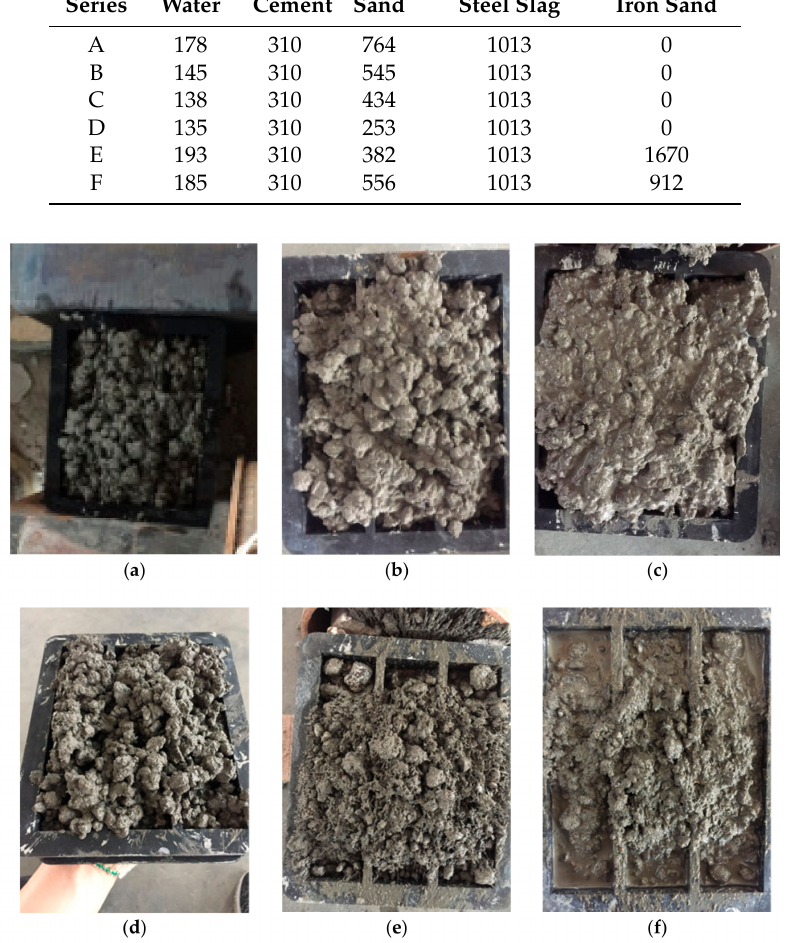
Figure 6. Effect of magnetic vibration for different magnetically driven mortar (MDM) series specimens: ( a ) Series A; ( b ) Series B; ( c ) Series C; ( d ) Series D; ( e ) Series E; ( f ) Series